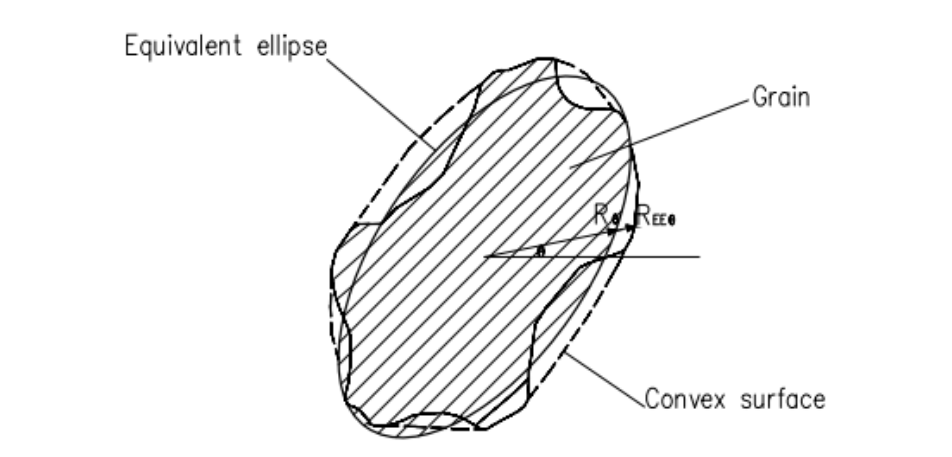
Figure 1. Schematic diagram of the particle equivalent ellipse and convex surface.